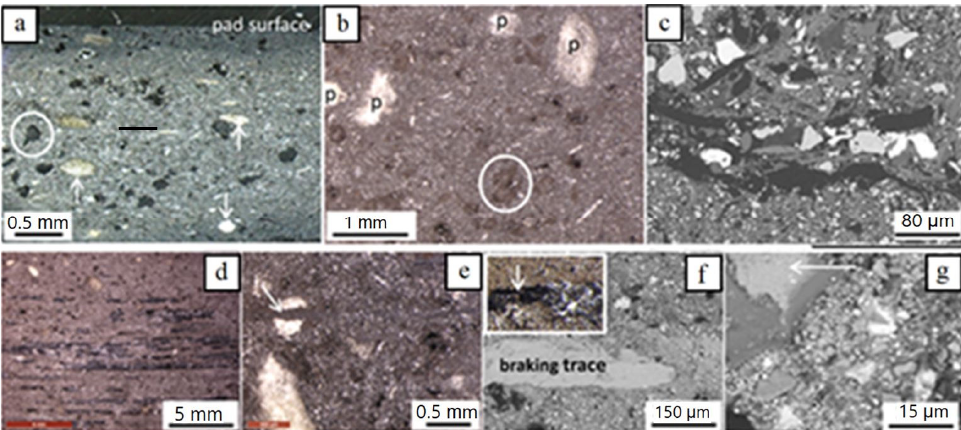
Figure 6. Light microscopy ( a , b , d , e and inset in f ) and BSE-SEM images ( c , f , g ) of the used brake pad. ( a ): Side view (profile) of the uppermost ~3 mm showing mainly the ‘very large’ constituents (carbon, partly encircled) and fiber-rich pockets, arrows; ( b ): pad surface with fiber-rich pockets ( p ), carbon (partly encircled and sheet-forming particles (thin white), as well as abundant brownish material partly altering the black color of carbon particles and pockets; ( c ) pad surface illustrating details of ‘large’ particles and matrix constituents; ( d ): pad surface with brownish material and braking traces (parallel black stripes); ( e ) pad surface with dispersed brownish material and a layer of it crosscutting a fiber-rich pocket (arrow); ( f ) detail of a braking line in SEM; inset shows the braking line in light microscopy); ( g ): detail of a braking line (arrow) and of brownish material in SEM (abundant fine grains in the largest part of the image). Images ( a , c , f , g ) are impregnated samples, all others untreated.